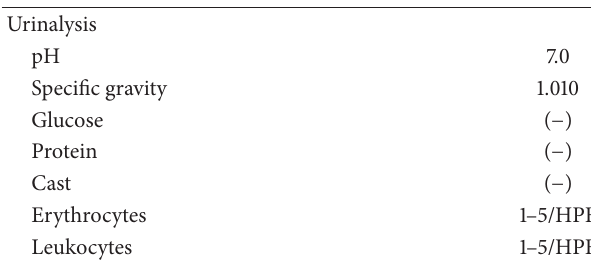
Table 1: Laboratory test values of the proband upon